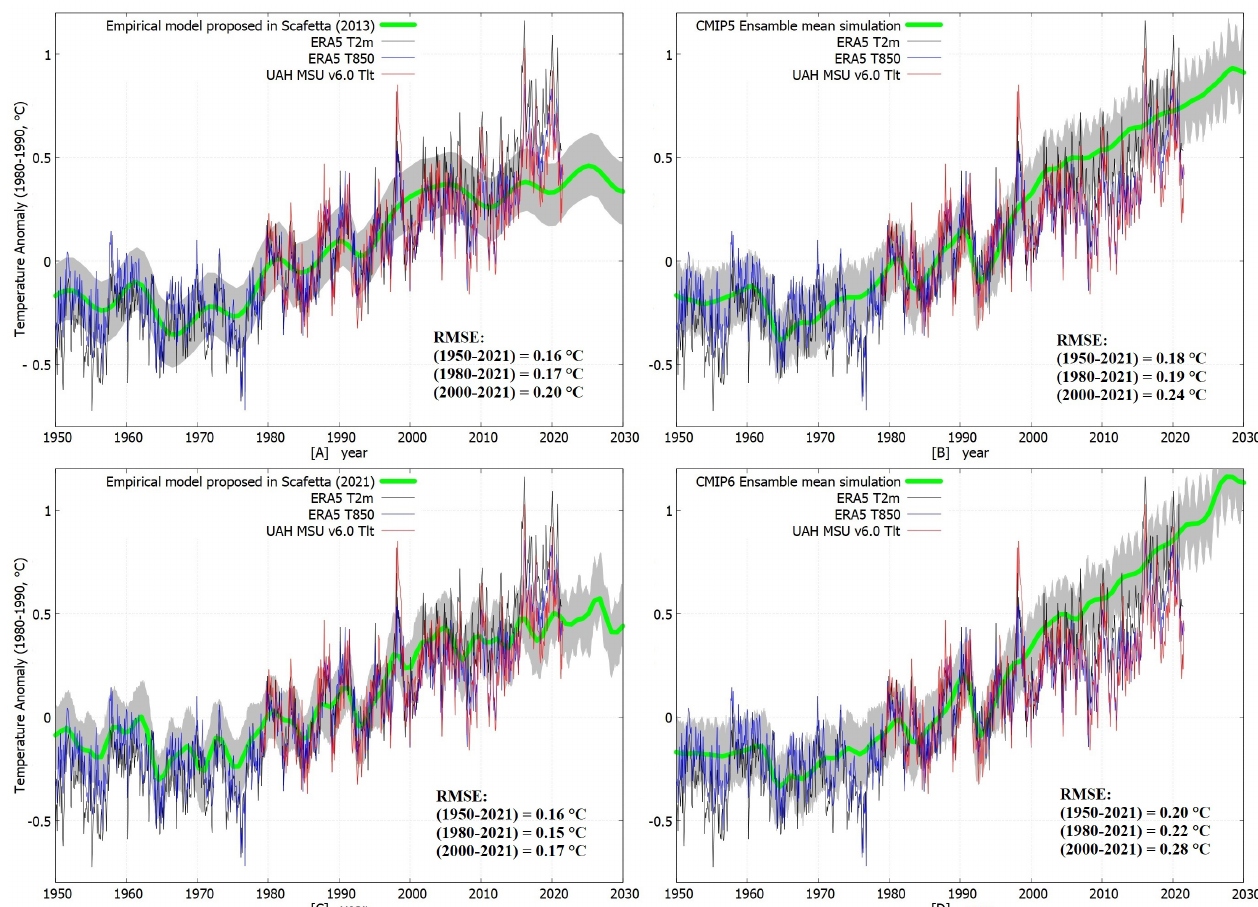
Figure 10. ERA5-T2m, ERA5-850mb, and UAH MSU v.6.0 Tlt against: ( A ) the semi-empirical model proposed in Scafetta [5], which uses 6 harmonics plus the volcano and anthropocentric component obtained from halving the CMIP5 ensemble mean simulation; ( B ) the CMIP5 ensemble mean simulation; ( C ) the semi-empirical model proposed in Scafetta [6] with 13 harmonics plus the volcano and anthropocentric component obtained from halving the CMIP6 ensemble mean simulation; ( D ) the CMIP6 ensemble mean simulation. The gray area is fixed at ± 0.15 °C, which approximately corresponds to the fluctuation range of the observations. Each panel also reports the RMSE values between the proposed model and the average among the three temperature records for the three indicated periods. Smaller RMSE values imply a better agreement between the two